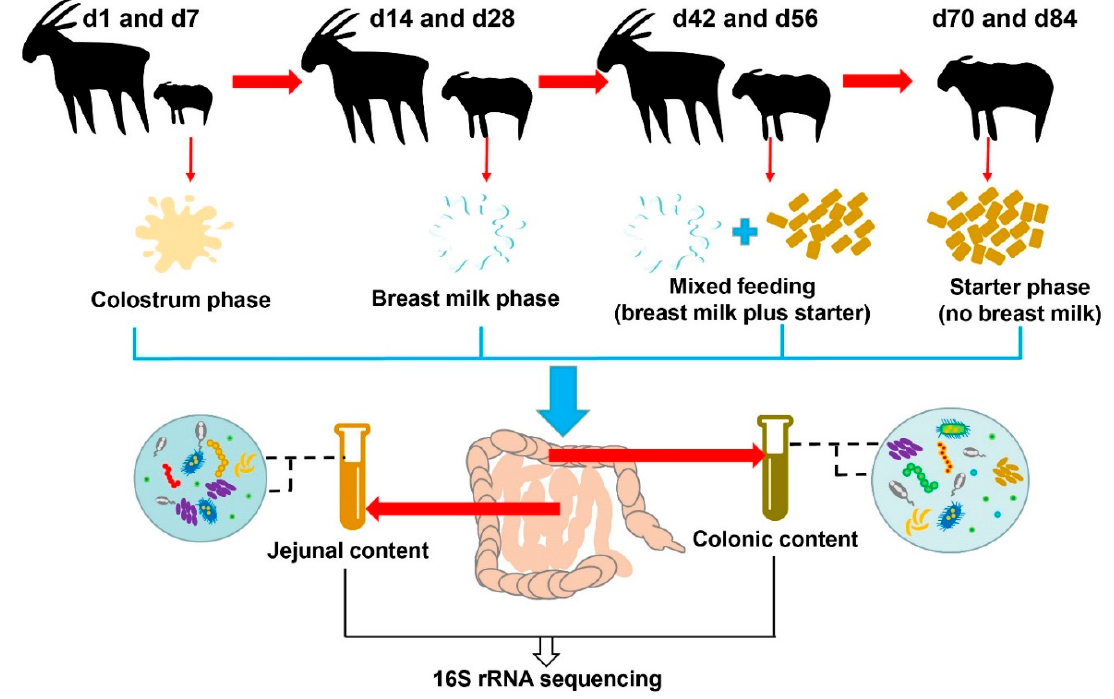
Figure 1. Experimental design and workflow.